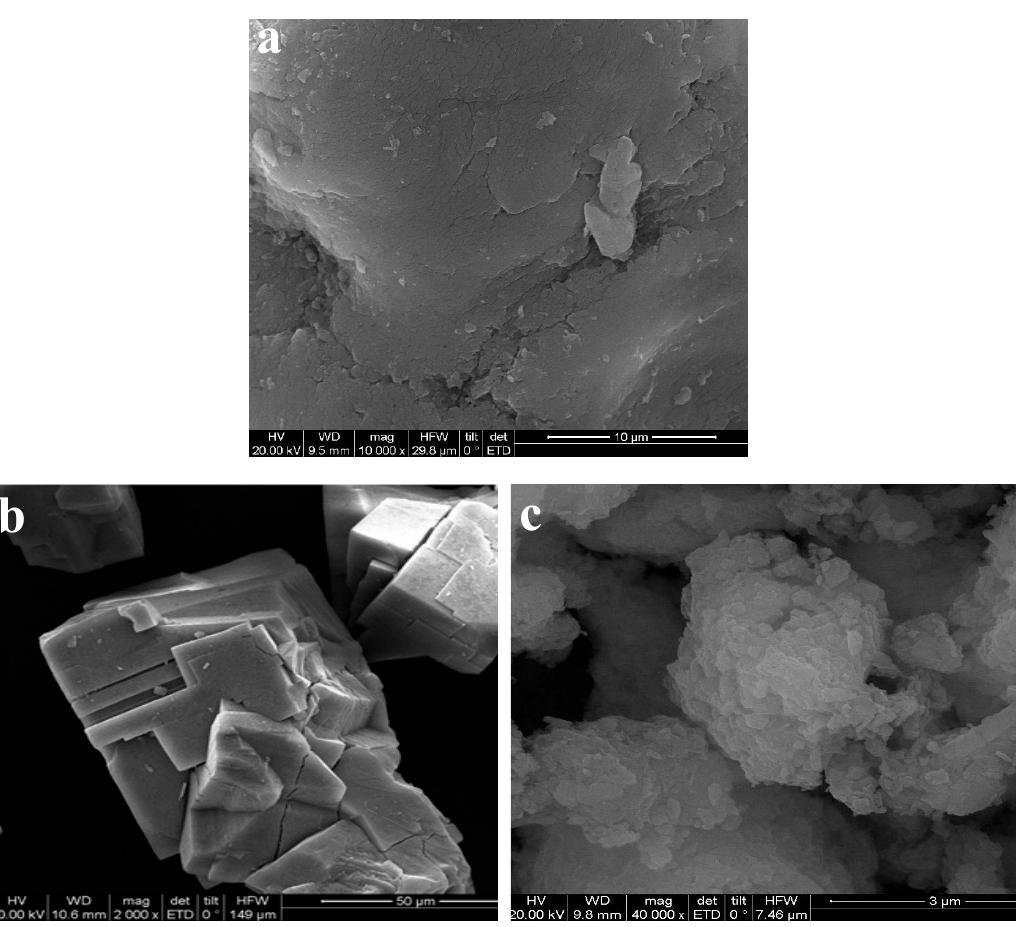
Figure 1. Scanning electron microscopy (SEM) images of ( a ) Carboxymethylcellulose (CMC), ( b ) MOF-5, and ( c ) MOF-5–CMC.